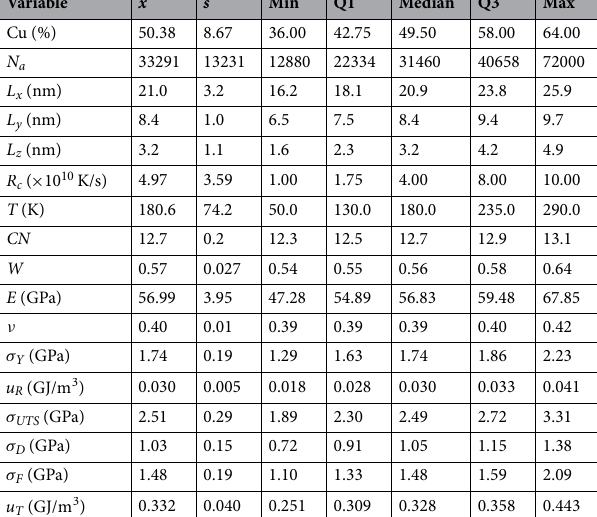
Table 1. Descriptive statistics for each feature under